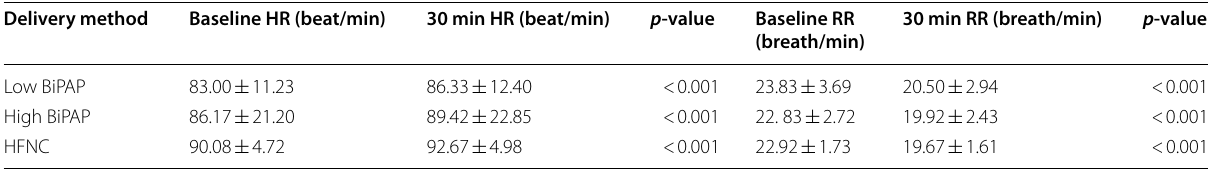
Table 2 Baseline and 30 min post-dose heart rate (HR) (beat/min) and respiratory rate (RR) (breath/min) of the patients who participated in the study ( n 12) = Delivery method